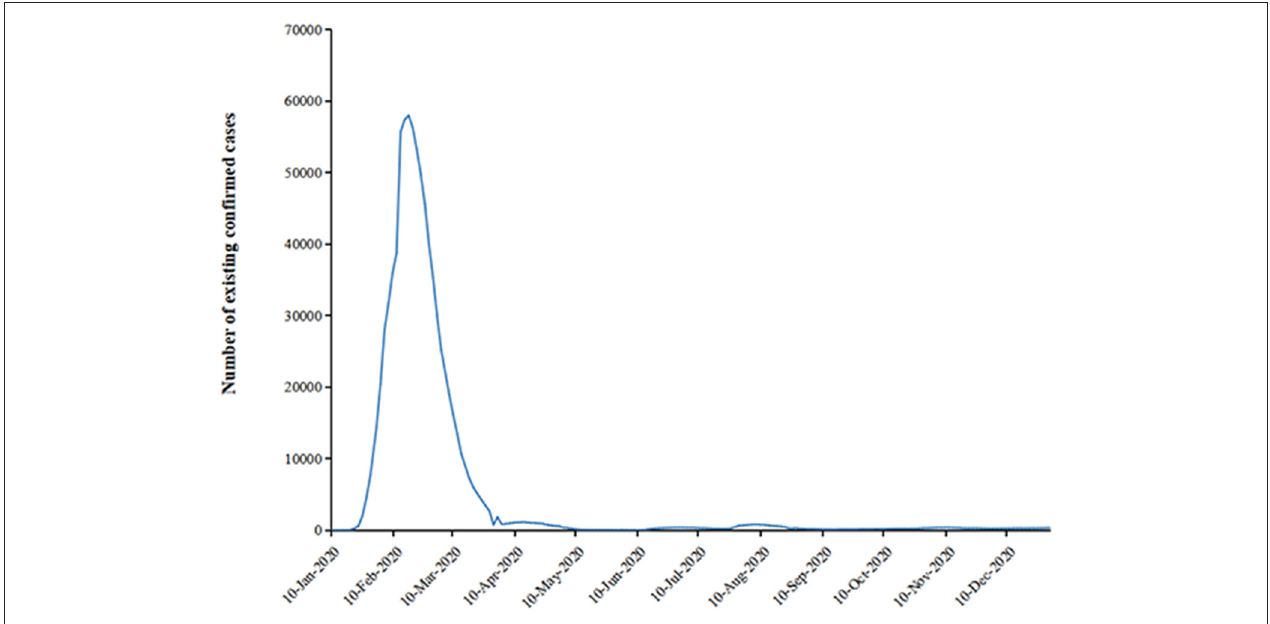
FIGURE 2 | Trends in the number of existing patients with COVID-19 in China in 2020.